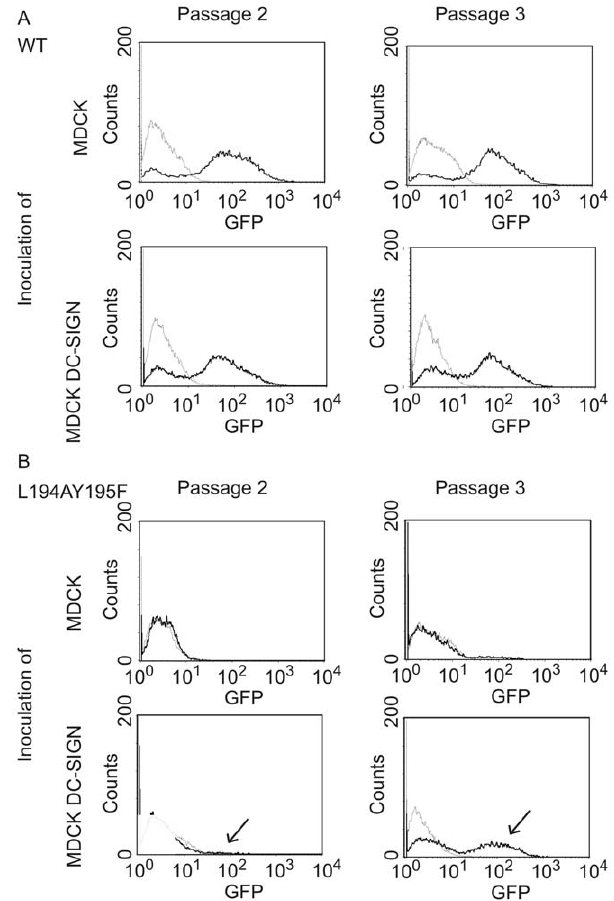
Figure 4. GFP expression after infection with L194AY195F-GFP and GFP-H1 in MDCK and DC-SIGN-expressing MDCK cells. MDCK and MDCK DC-SIGN cells were inoculated with influenza viruses GFP-H1 (A) and L194AY195F-GFP-H1 (B) at a MOI of 0.01 (solid lines). Both viruses were passaged in MDCK-DC-SIGN cells two or three times as indicated. Twenty-four hours post inoculation the cells were tested for GFP expression by flow cytometry. Uninfected cells were included as negative controls (dotted lines). Infection experiments with GFP-H1 virus passaged in MDCK cells essentially gave the same results as the virus passaged in MDCK DC-SIGN cells (data not